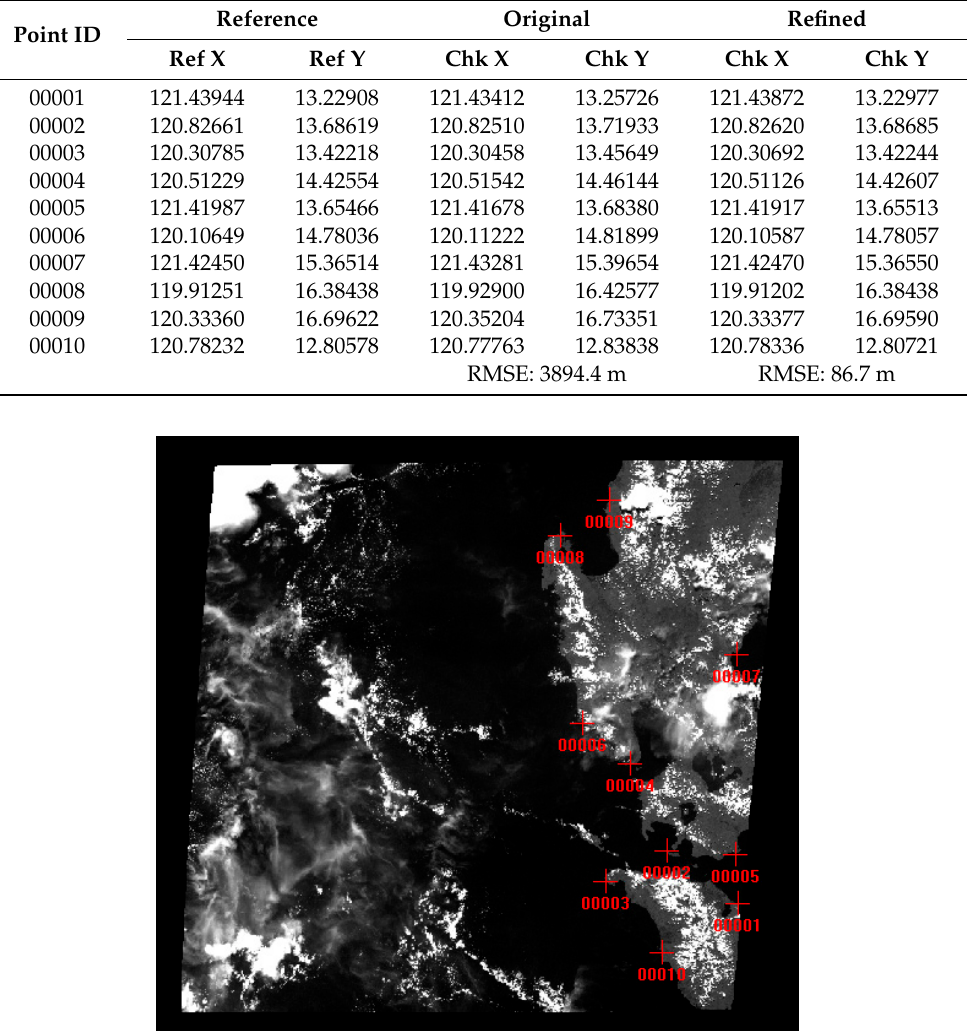
Table 4. This table shows the checking points list.